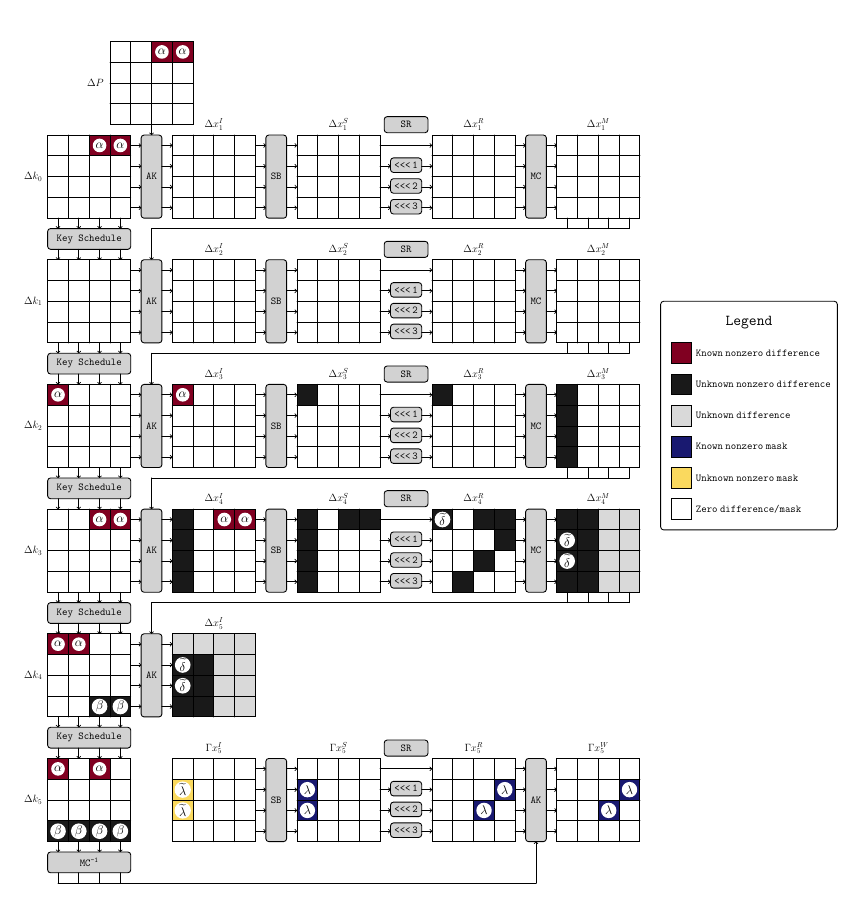
Figure 3: 5-round related-key differential-linear distinguisher